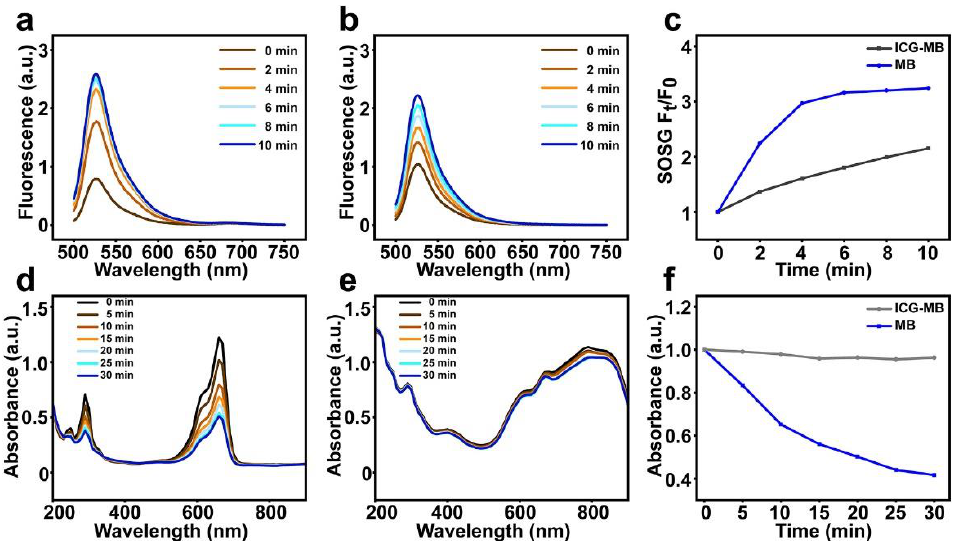
Figure 3. ( a , b ) Fluorescence spectrum of SOSG in the presence of free MB ( a ) or ICG-MB ( b ) under 670 nm laser irradiation. ( c ) Normalized fluorescence intensity of SOSG at 530 nm. ( d , e ) UV-vis-NIR absorption spectra of free MB ( d ) and ICG-MB ( e ) with 808 nm irradiation for different times. ( f ) Normalized absorbance of ICG-MB and free MB after irradiation with different times.